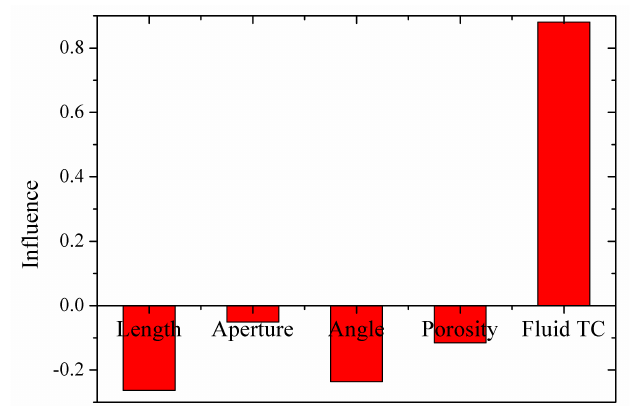
Figure 8. The influence degrees of parameters in effective thermal conductivity (ETC) prediction from partial least squares (PLS) analysis.